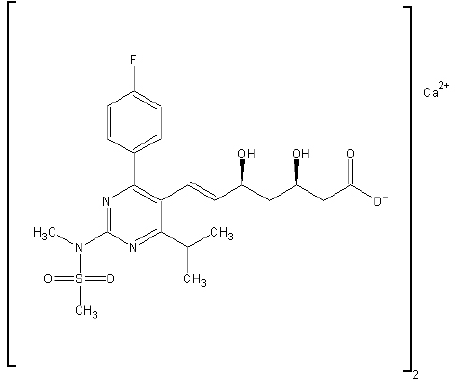
FIGURE 1 - Structure of